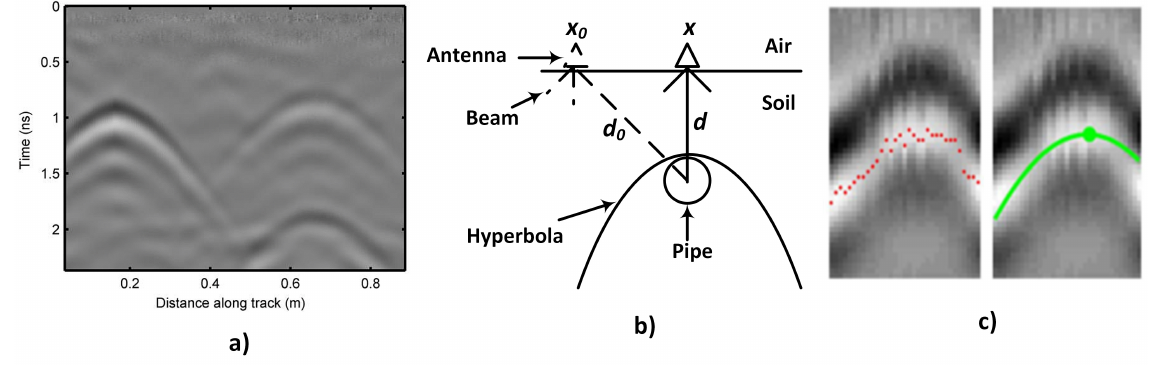
Figure 10. ( a ) GPR image showing three hyperbolas [59]; ( b ) formation of diffraction hyperbola; ( c ) hyperbola curve fitting